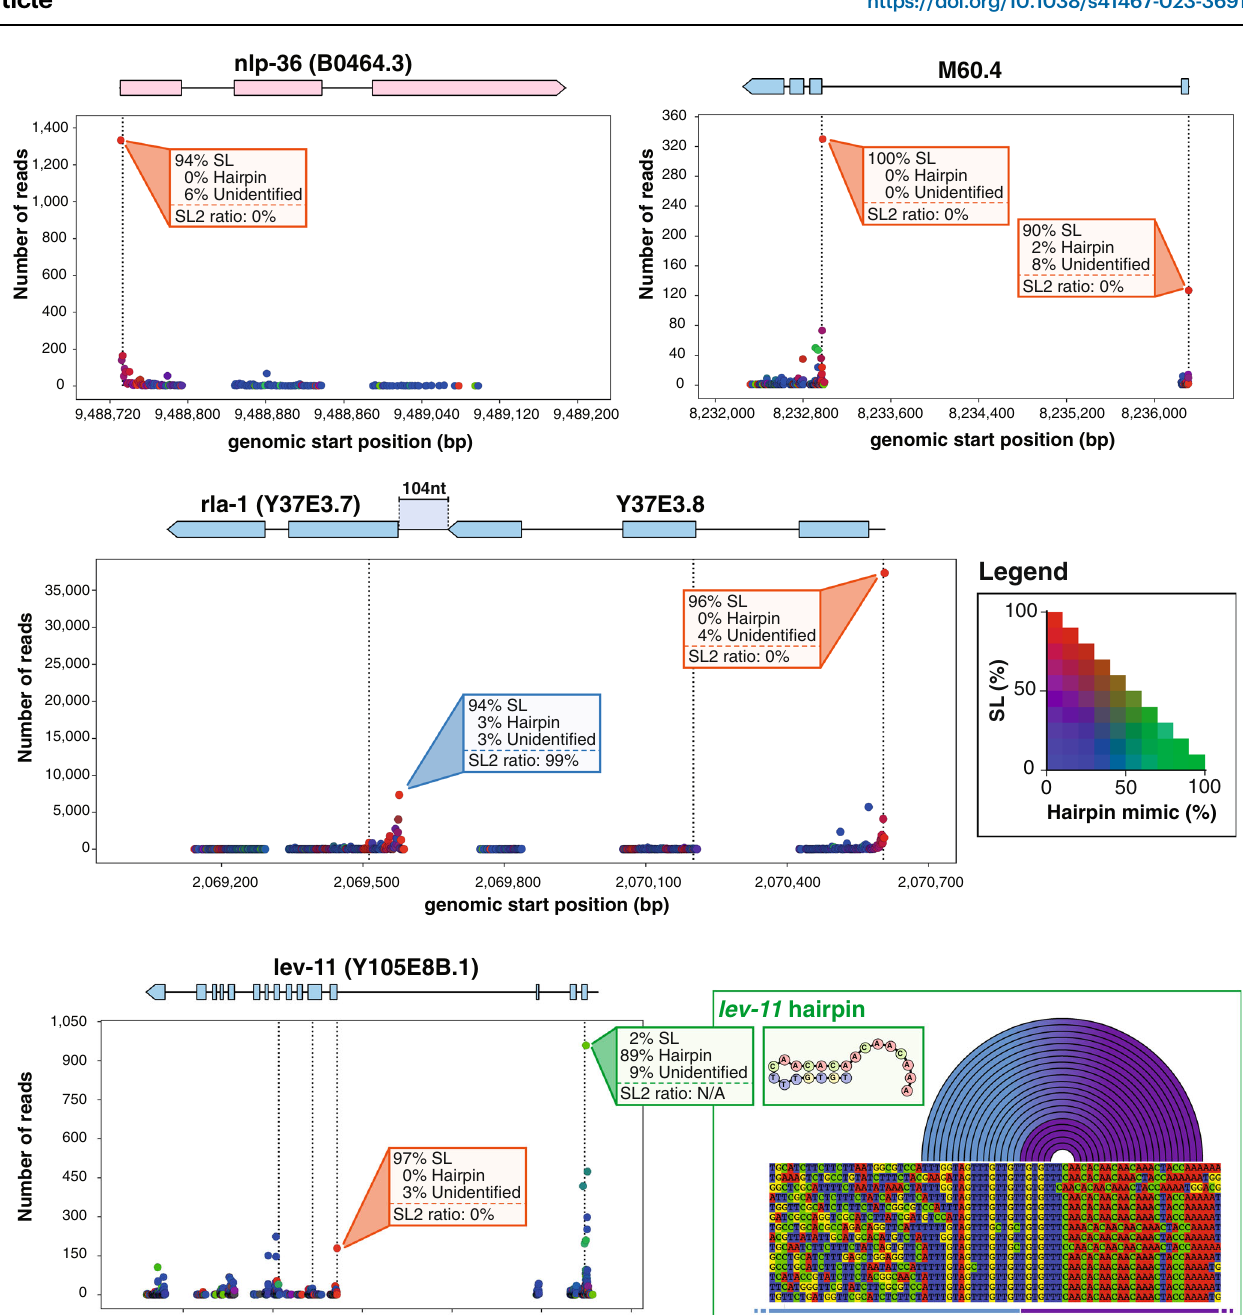
Fig. 6 | Schematic representation of individual gene trans -splicing. Each alignment start position observed was plotted at the corresponding genomic position with the number of supporting reads. The dots are colored according to the legend on the right, with red indicating a majority of SL reads, green a majority of endogenous hairpin reads and blue reads with no evidence for either. Dotted vertical lines indicate the position of a putative start codon. nlp-